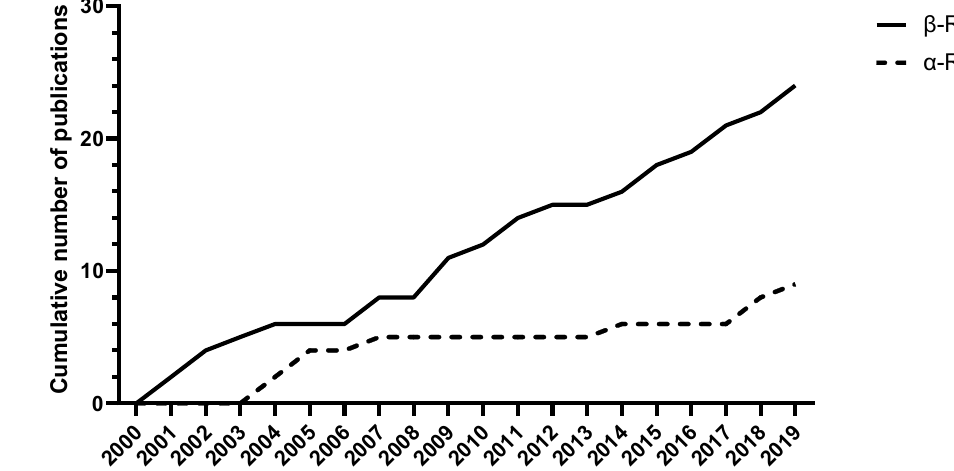
Figure 3. Cumulative distribution of identified publications RIT for PDAC since 2000.